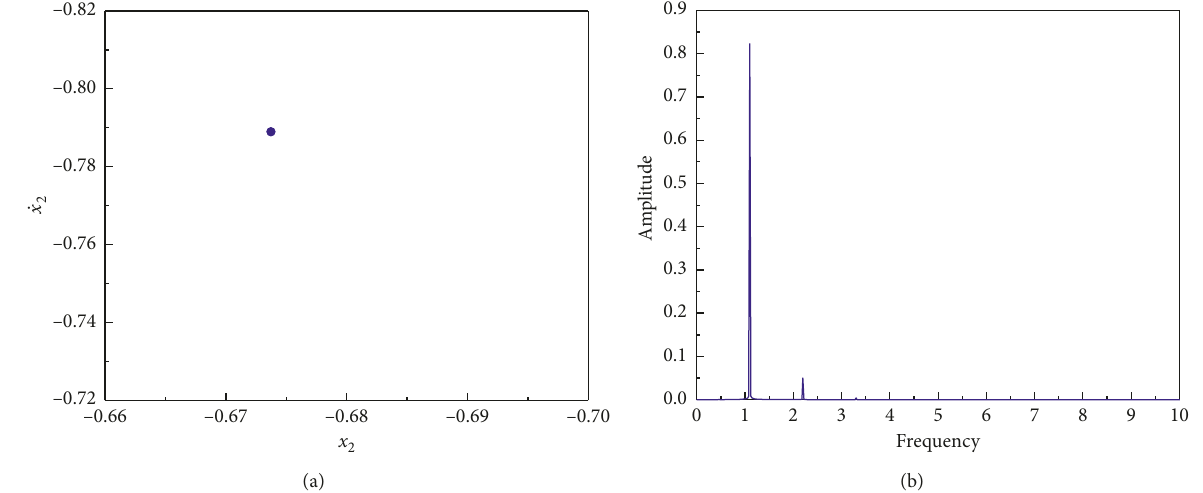
Figure 18: Period-1 motion of the baseplate for Ω �